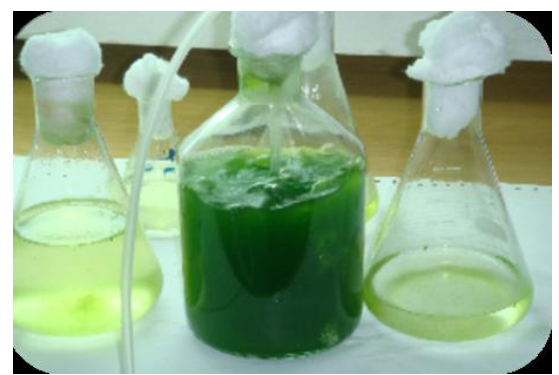
Figure 1. Photo of the cultivation system of isolated algal species.